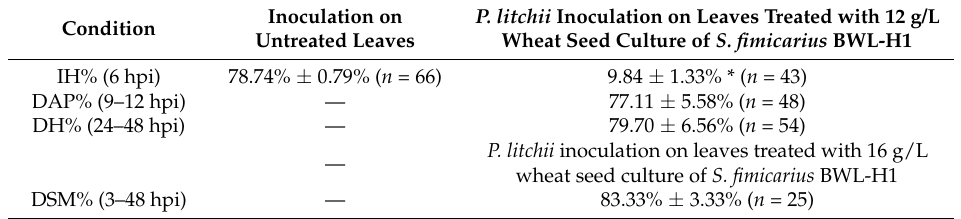
Table 1. Quantification of deformed structures of P. litchii caused by treatment of wheat seed culture of S. fimicarius BWL-H1, during infection process.